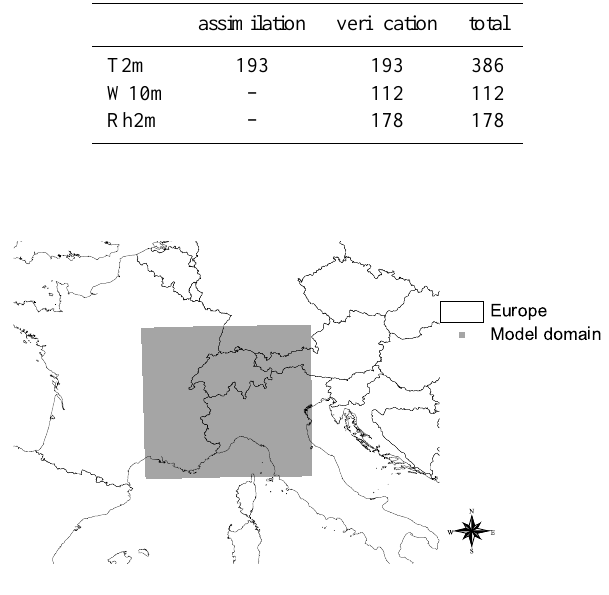
Fig. 3. Domain of the simulations.